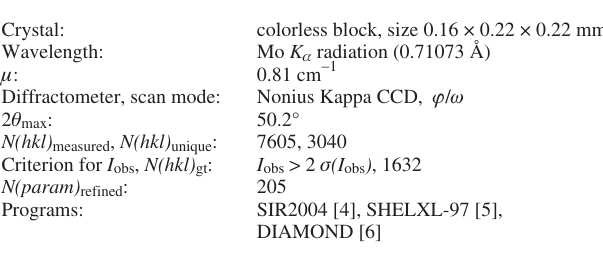
Table 1. Data collection and